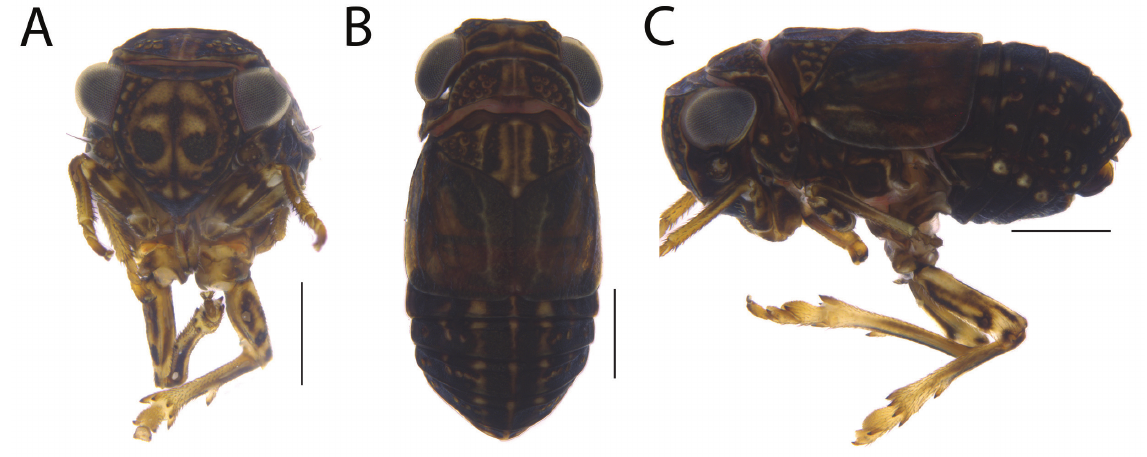
Fig. 1. Habitus of Aphelonema brevata Caldwell, 1945, ♂ (INHS). A . Frontal view. B . Dorsal view. C . Lateral view. Scale bars = 0.5